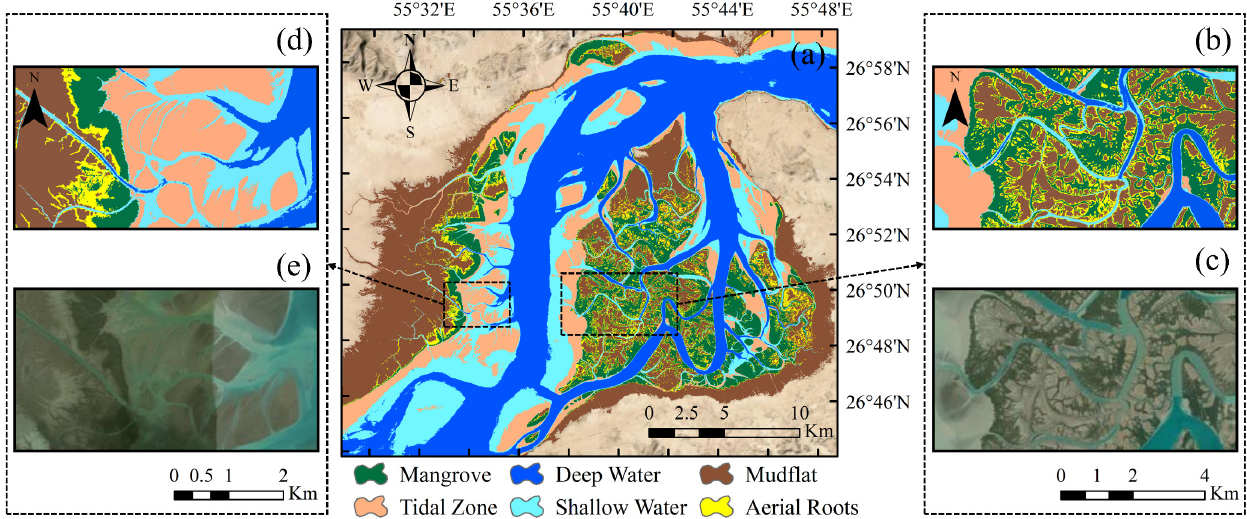
Figure 3. Mangrove ecosystem map of the study area produced using the random forest (RF) algorithm and a combination of the Sentinel-1 and Sentinel-2 satellite images within the Google Earth Engine (GEE) platform ( a ), two zoomed areas of the produced map ( b , d ), and their corresponding high-resolution satellite images for better visualization ( c , e ).